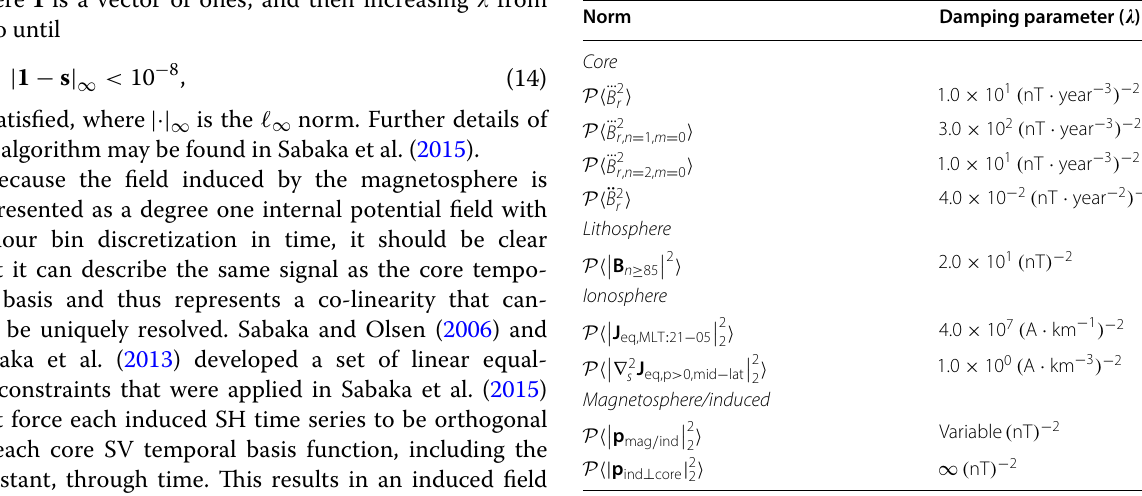
Table 4 CIY4 damping parameter